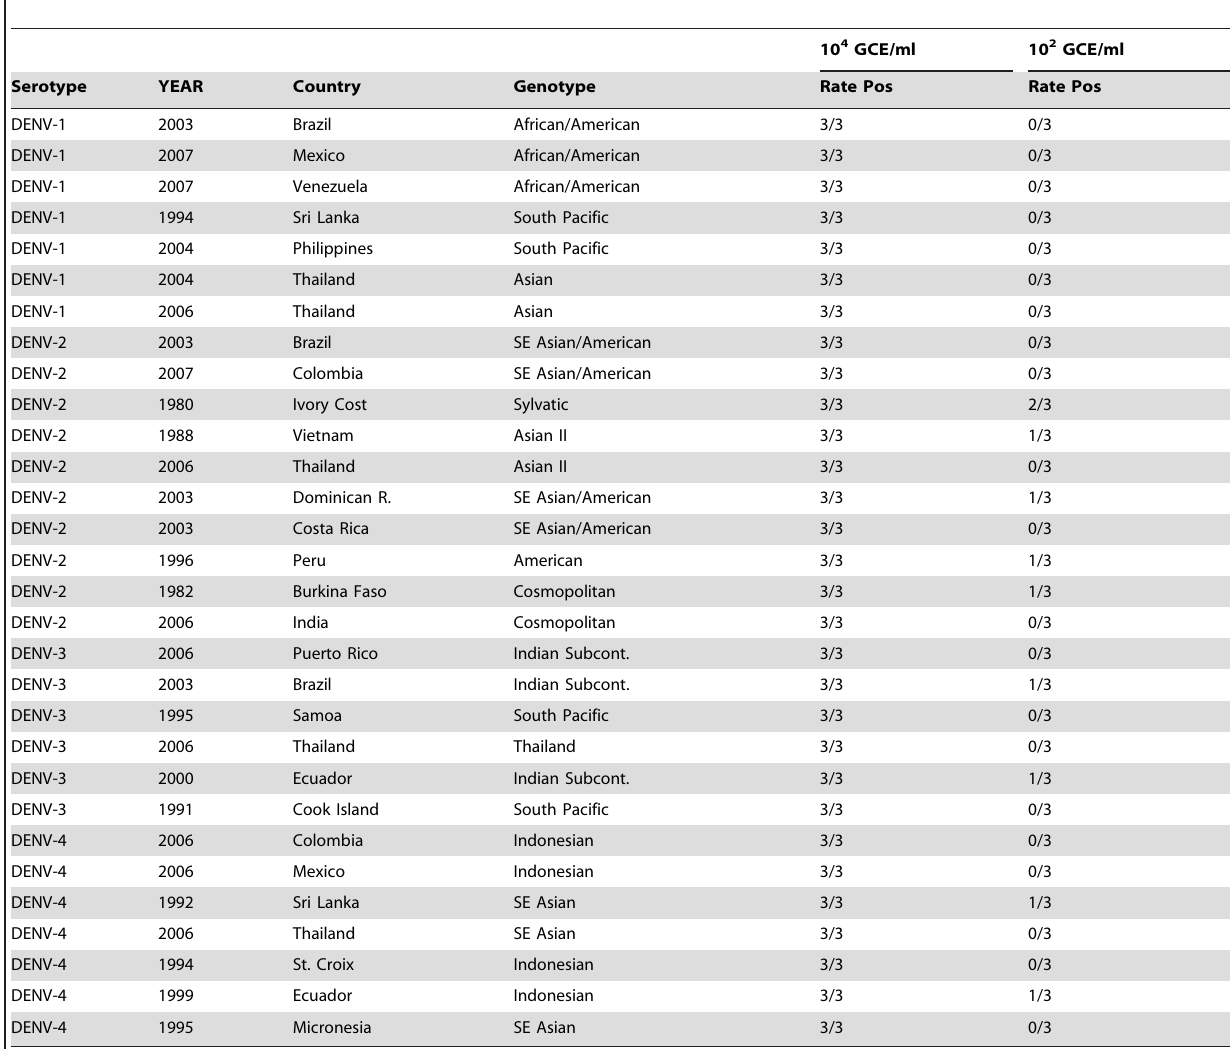
Table 2. Detection of international strains: (10 4 GCE/mL) above and below (10 2 GCE/mL) the limit of detection.